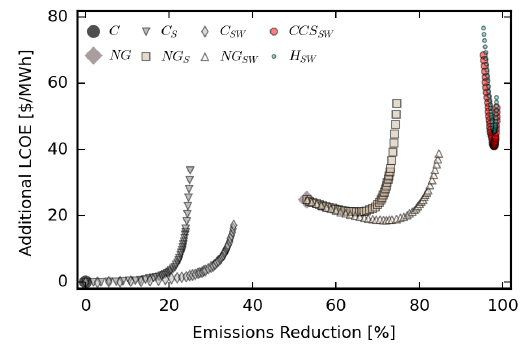
Figure 16. Lifetime CO 2 emissions reduction from current Kentucky generation vs. LCOE of gener- ation portfolio construction and operation for a 30 year period. The introduction of VRE reduced emissions and the LCOE non-linearly increased with higher renewables penetration. Operation, maintenance, and fuel costs lead to an increased gap in cost between coal, natural gas, and low-carbon dominant